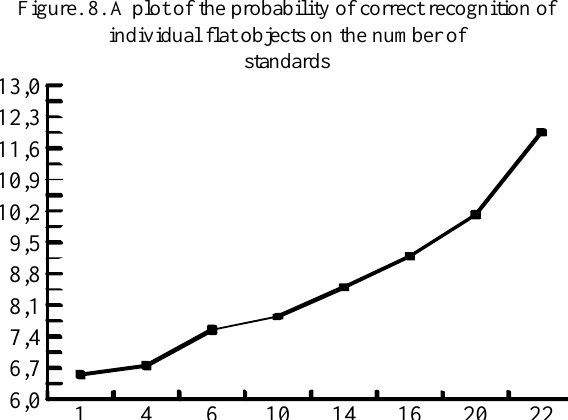
Figure. 11. Schedule change the time of a complex object recognition on the number of